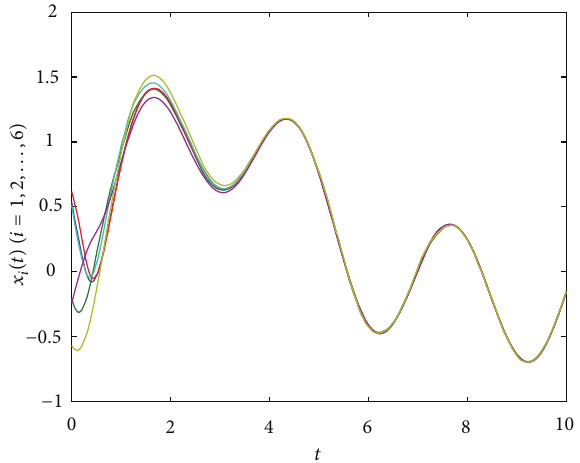
Figure 2: The position curves 𝑥 𝑖 (𝑡) (𝑖 = 1,2, . .. ,6) for nonlinear multiagent systems (43) with 𝜏 0 = 0 , 𝜏 1 = 0.3 .